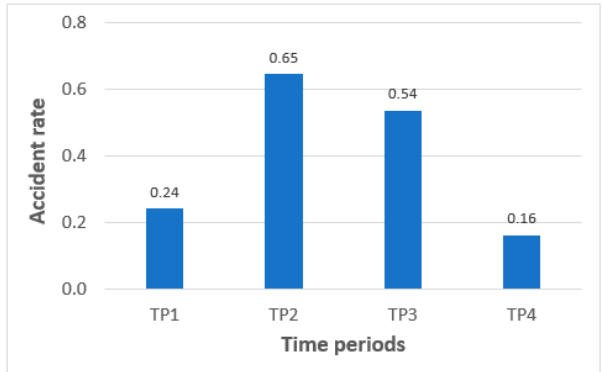
Figure 7. Comparison of accident rates in the analysed time periods.